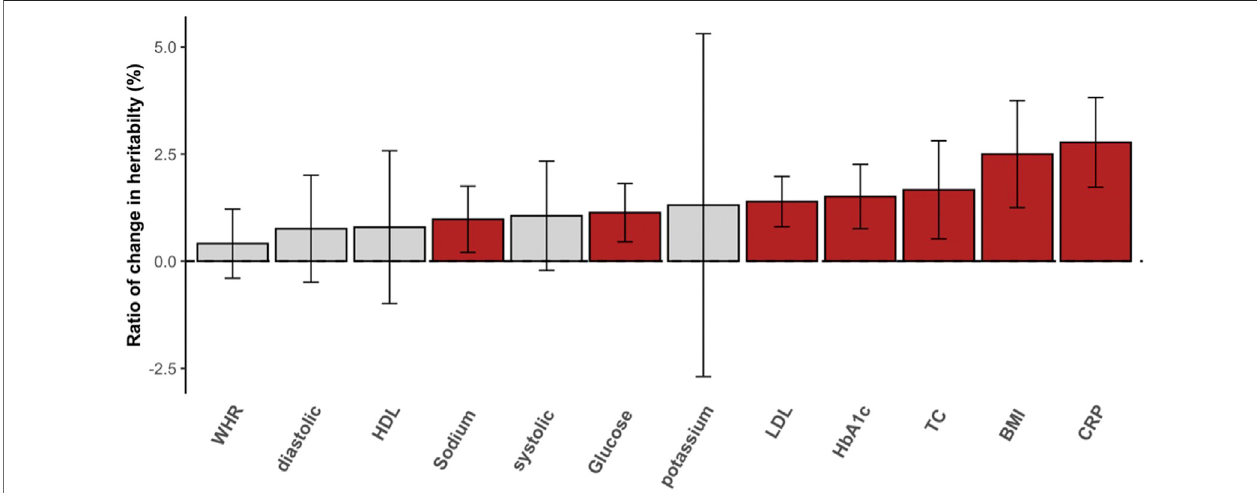
FIGURE 3 | The ratio of change in SNP heritability. The differences between heritability estimates from the GREML and MRNM were represented as the ratio of changeinheritability(%).Eachbarindicatesthedifferencesinheritability,andtheratiowascalculatedas( h 2 MRNM − h 2 GREML )/ h 2 GREML ,where h 2 MRNM and h 2 GREML indicatethe estimatedheritabilityfromMRNMandGREML,respectively.Therefore,thepositiveratiodenotesthatestimateofMRNMishigherthanthatofGREML.Theverticallineis the 95%con fi dence interval oftheratioaveraged overthe analyses ofeach traitwithsigni fi cantoverall interaction. Traits withsigni fi cantdifference betweenMRNM and GREML are colored red. The interaction analyses of 69 pairs with signi fi cant overall interactions were used in the heritability comparisons. WHR, waist-hip ratio; diastolic, diastolic blood pressure; HDL, high density lipoprotein cholesterol; sodium, sodium in urine; LDL, low density lipoprotein cholesterol; potassium, potassium in urine; TC, total cholesterol; HbA1c, haemoglobinA1C; BMI, body mass index; CRP, C reactive protein; systolic, systolic blood